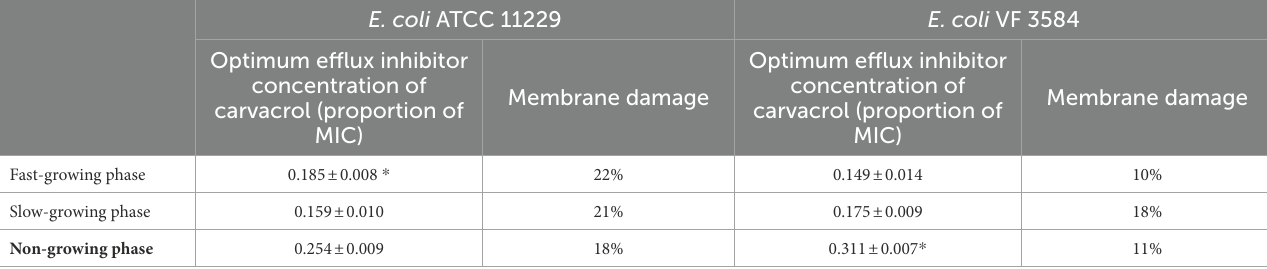
TABLE 1 Optimum efflux inhibitor concentrations of carvacrol against two Escherichia coli strains and the associated membrane damages (%) as a function of the bacterial physiological